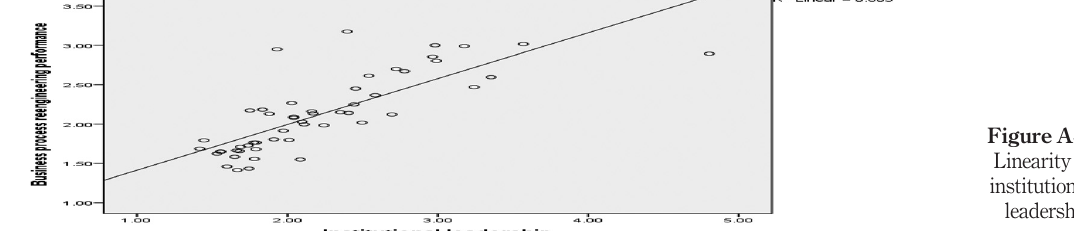
Figure A4. Linearity of